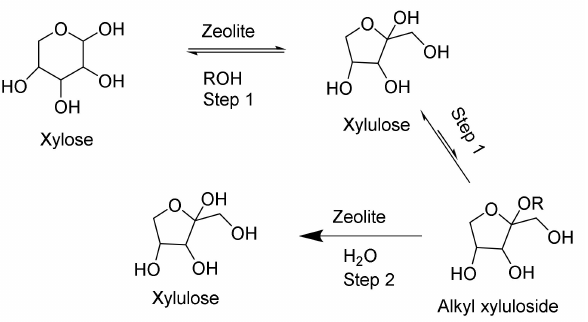
Figure 9. Reaction pathways for the conversion of xylose to xylulose and alkyl xyluloside.